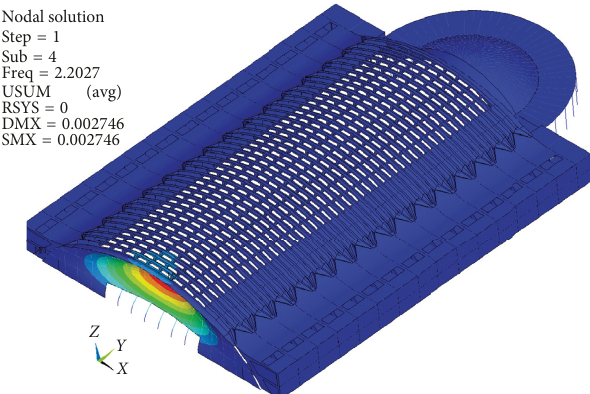
Figure 8: Mode 4 of Hall B (front